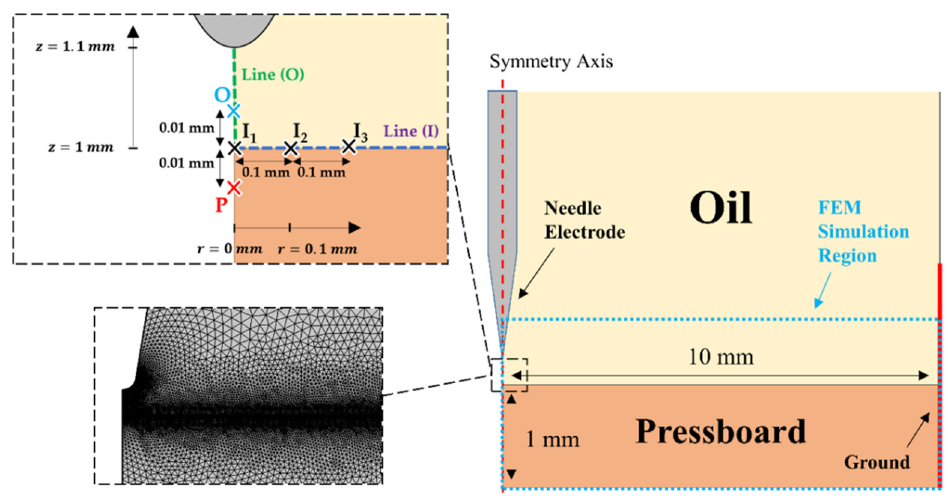
Figure 1. Schematic illustration of the studied geometry (2D axisymmetric) and the used